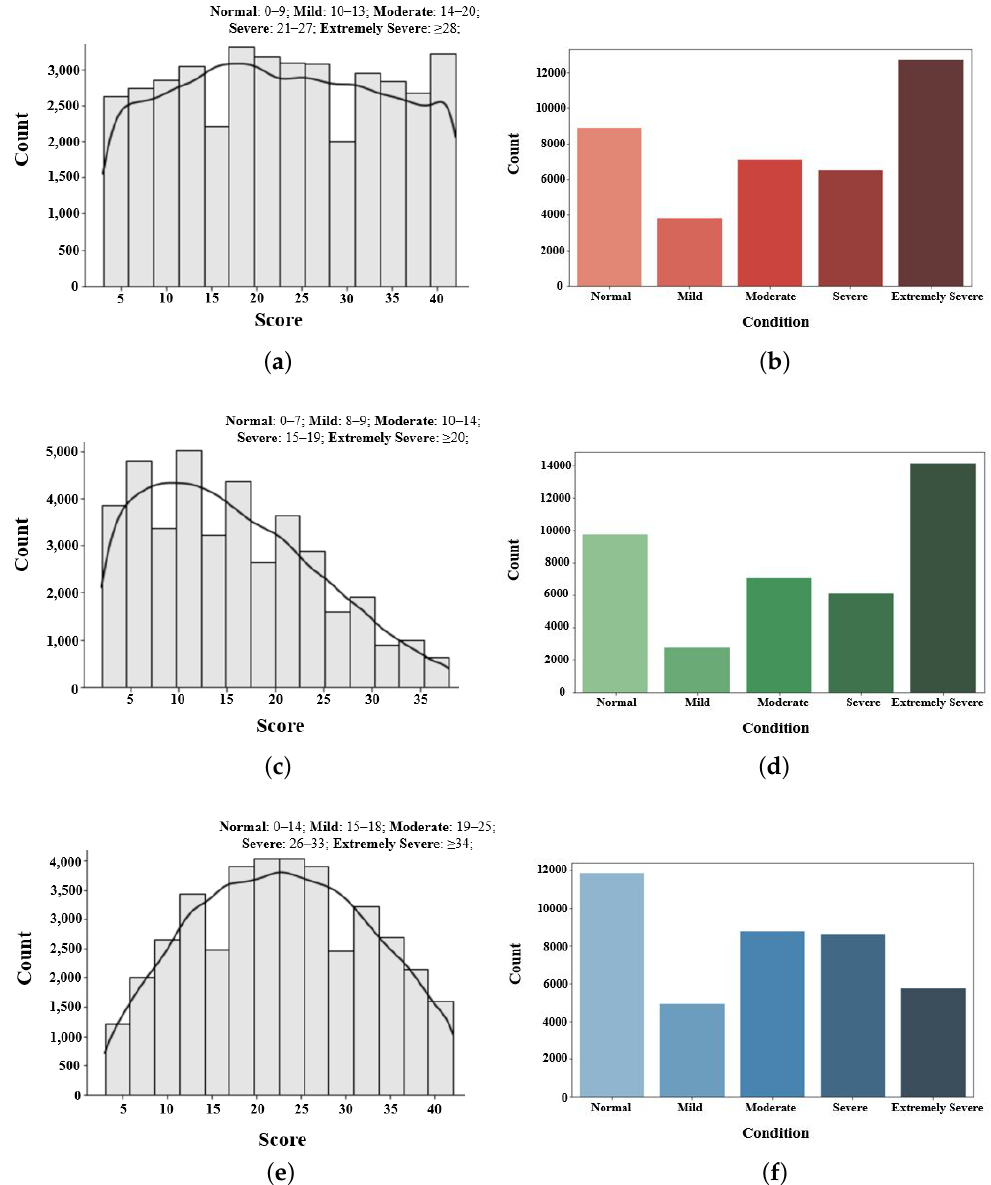
Figure 4. Distribution of DASS dataset’s score and severity. ( a , b ) Depression scale. ( c , d ) Anxiety scale. ( e , f ) Stress